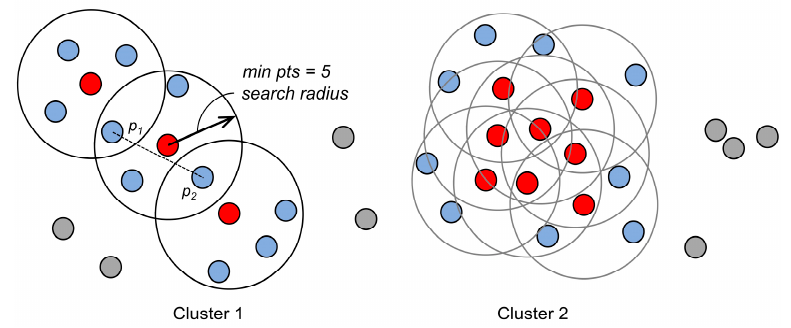
Figure 8. The DBSCAN algorithm and two generated clusters. There are three types of points as follows: key points ( red ) are points that satisfy the cluster criteria (termed core points by Ester et al. [65]); border points ( blue ) do not satisfy the cluster criteria but are within a key point’s reach; noise points ( grey ) are neither of the two aforementioned types. The DBSCAN algorithm uses the two following rules: (1) points within the search radius of a key point are part of its cluster and (2) key points which share common border points are part of the same cluster, shown for p 1 and p 2 in Cluster 1. Adapted from Tonini and Abellan [11].